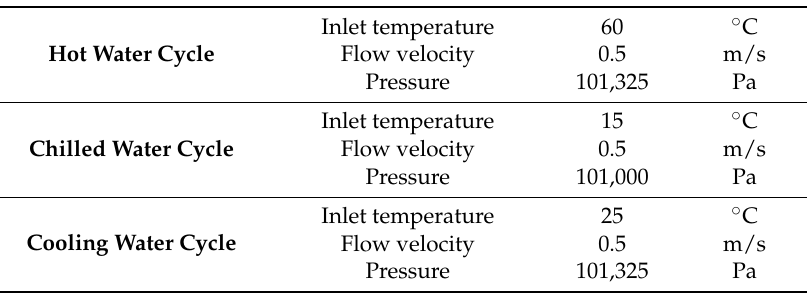
Table 3. Temperature